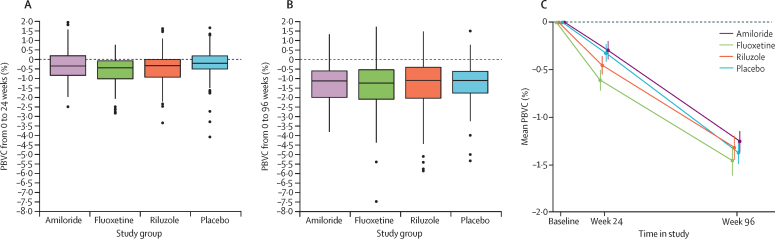
Primary outcomeBoxplots of PBVC by study group at 24 weeks (A) and 96 weeks (B). Horizontal lines are median and IQR; whiskers extend to the minimum and maximum within 1·5 times the IQR; outliers are shown as individual points. Mean PBVC by study group (C), for patients with PBVC data at both 24 and 96 weeks (n=374); whiskers are SD. PBVC=percentage brain volume change.